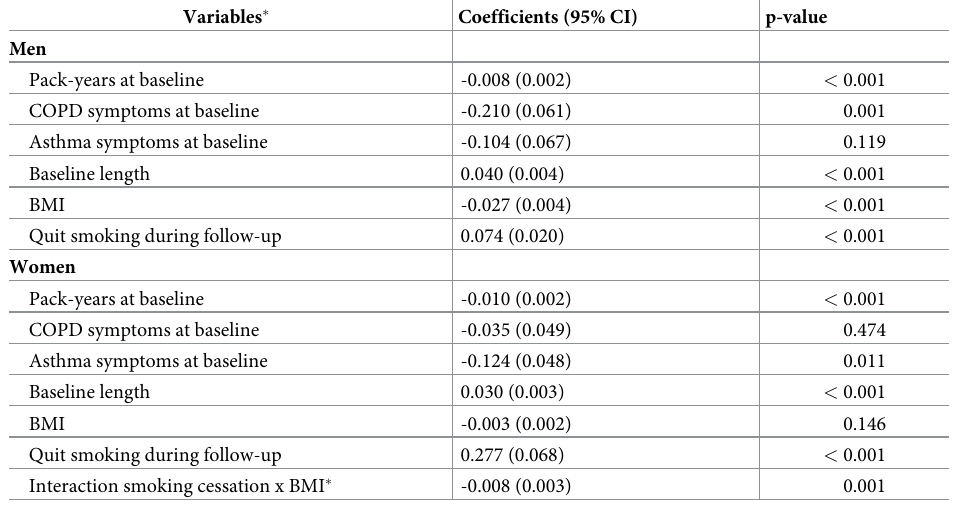
Table 6. The effects of smoking cessation during follow-up, adjusted for baseline variables and for BMI. Variables (cid:3)